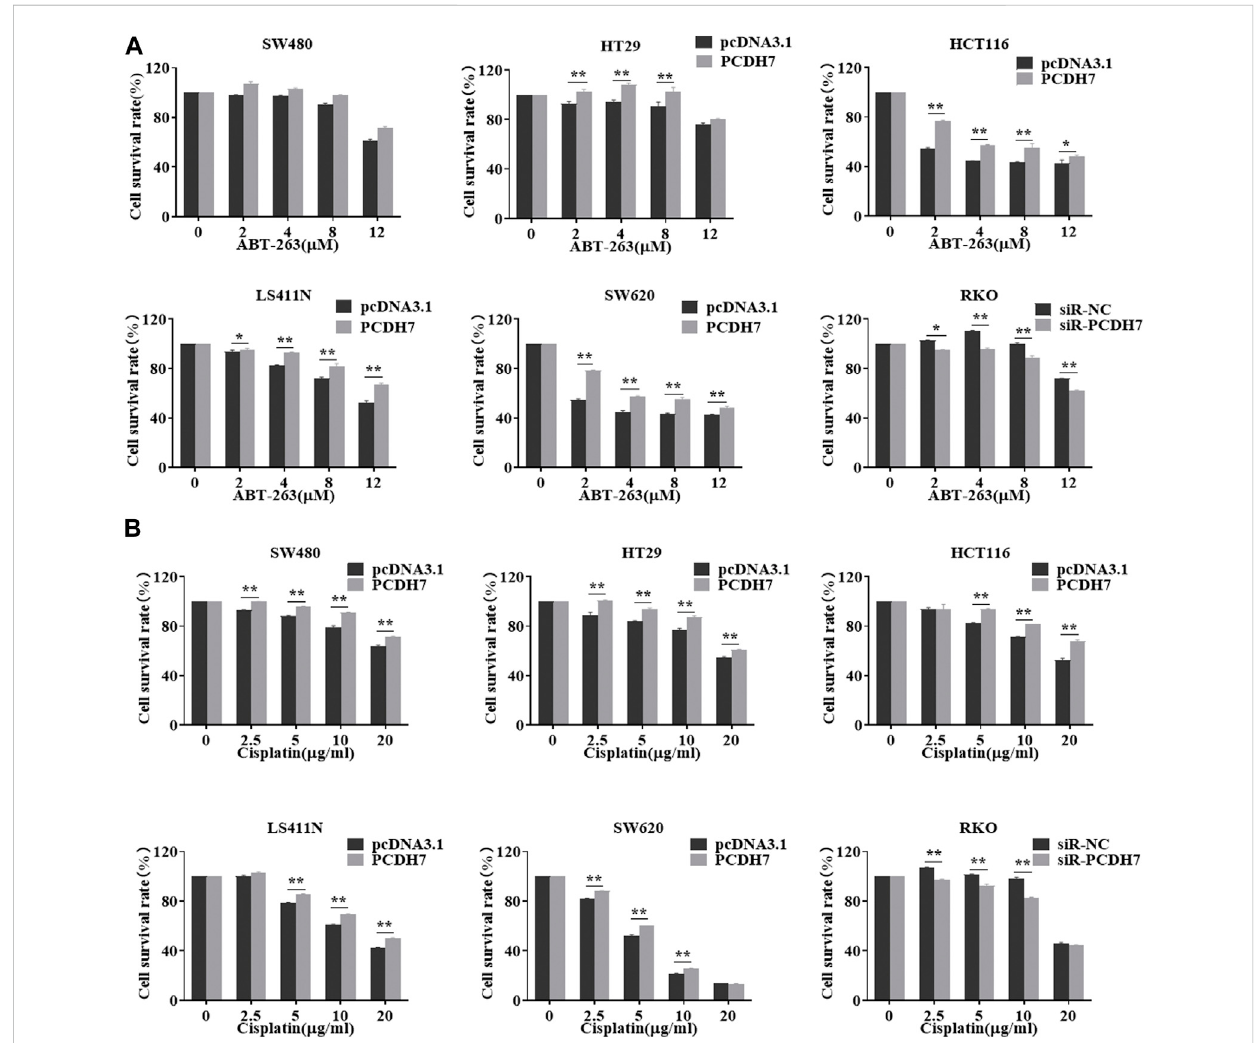
Effects of PCDH7 on the resistance of colorectal cancer cells. (A) MTT assays were performed to determine the cell viabilities of SW480, HT29, HCT116, LS411N, SW620, and RKO cells with the treatment of ABT-263 under PCDH7 overexpression or silencing. (B) MTT assays were performed